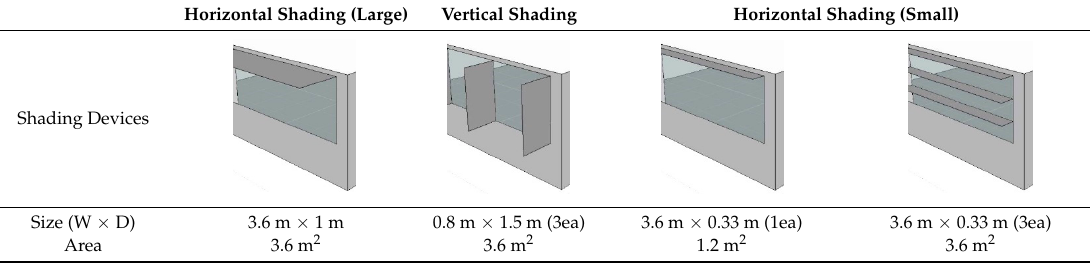
Figure 4. Shading mask of the direct beam in the middle of the window with facing south and west. Table 2. Different size and shape of shading device. Table 2. Different size and shape of shading device. Table 2. Different size and shape of shading device. Table 2. Different size and shape of shading device. Table 2. Different size and shape of shading device. Table 2. Different size and shape of shading device. Table 2. Different size and shape of shading device. Table 2. Different size and shape of shading device. Table 2. Different size and shape of shading device. Table 2. Different size and shape of shading device. Table 2. Different size and shape of shading device. Table 2. Different size and shape of shading device. Table 2. Different size and shape of shading device.